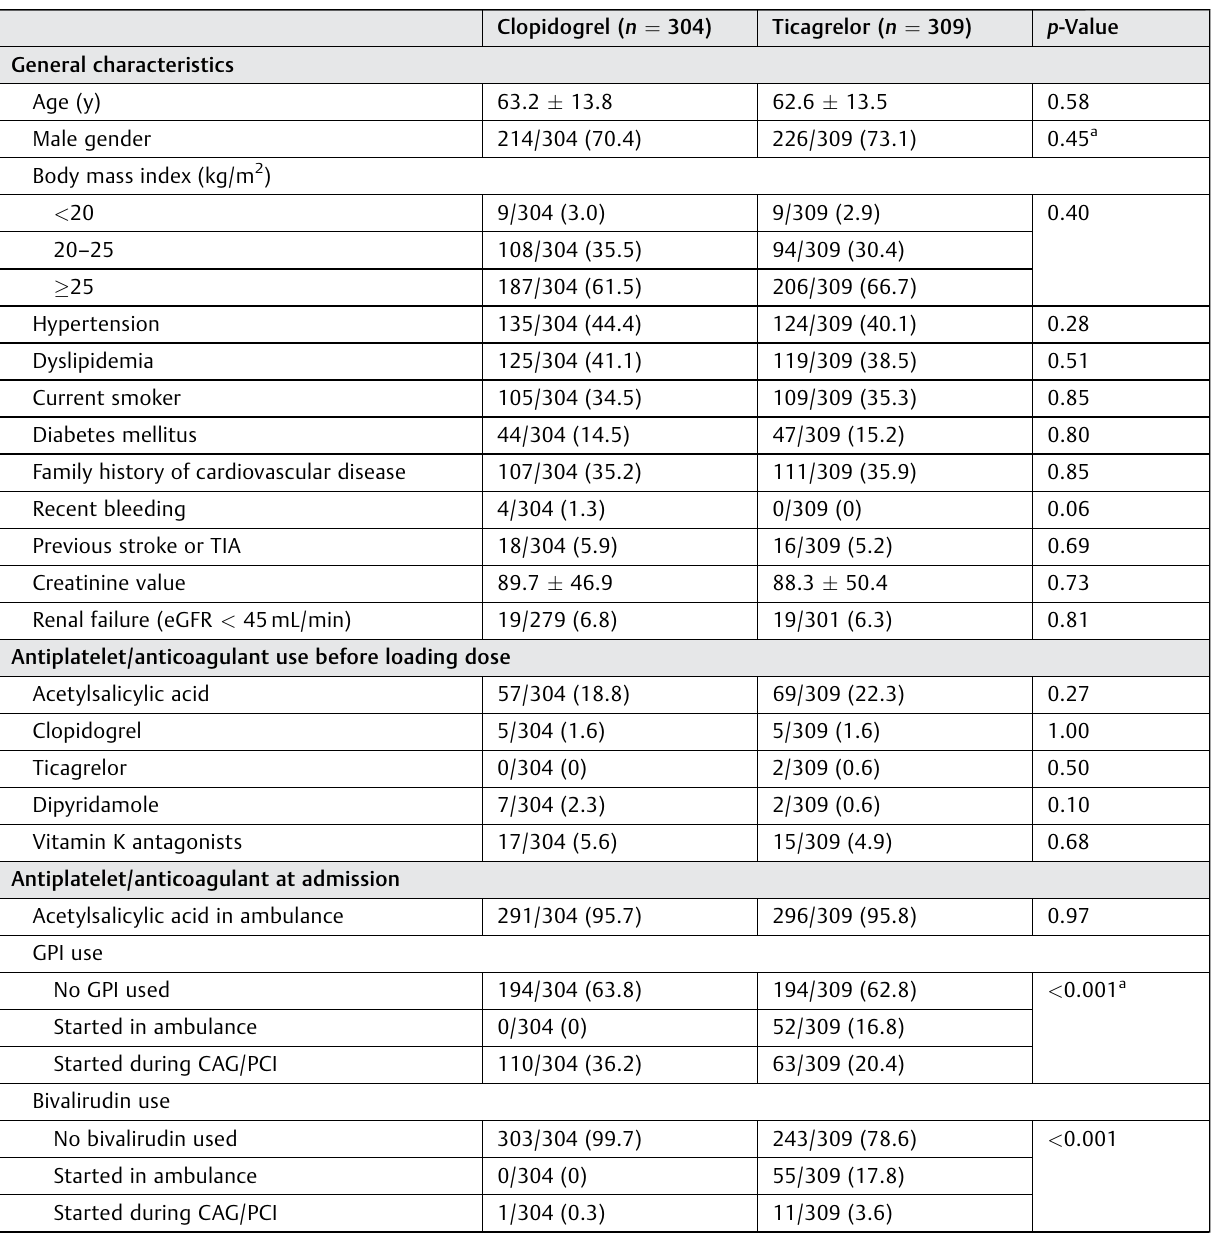
Table 1 Baseline